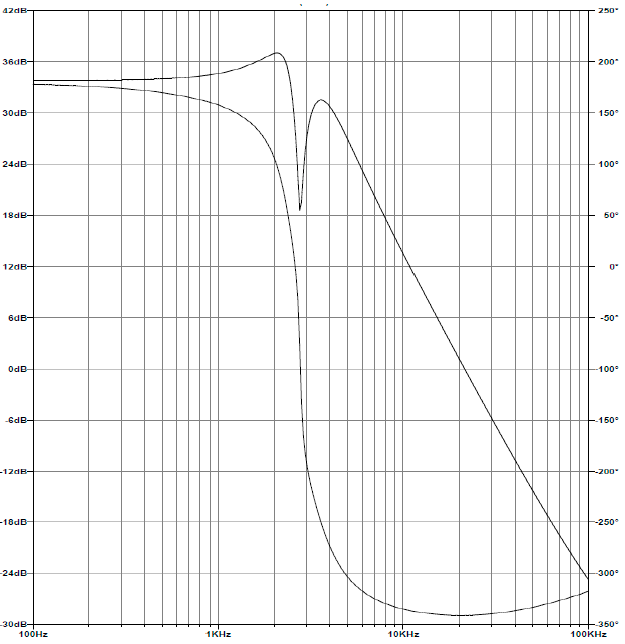
Figure 16. G vd for Cuk for variable R.